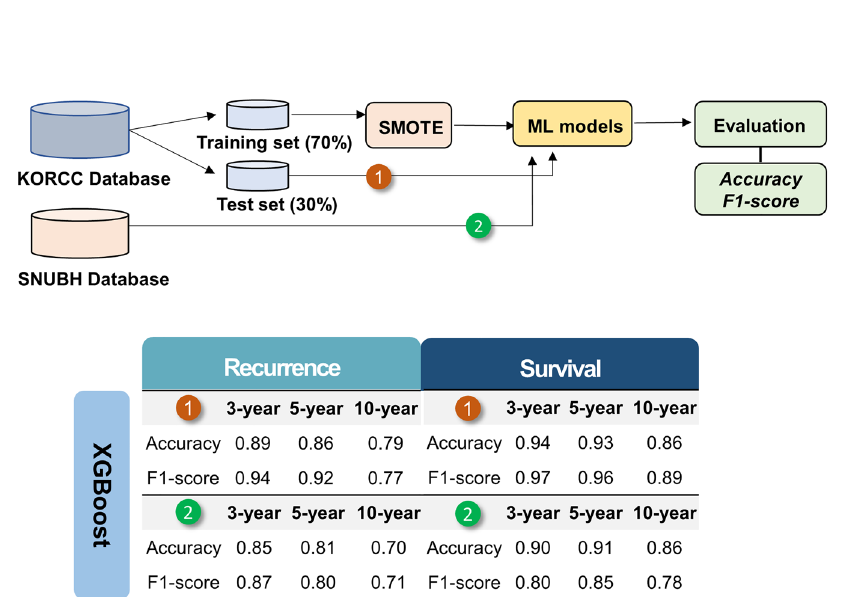
Table 3. Diagnostic performance of machine learning algorithms for the prediction of recurrence and